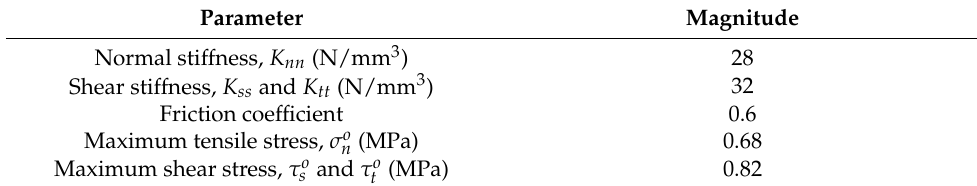
Table 4. Mechanical properties of the cohesive interfaces. Parameter Magnitude Normal stiffness, K nn (N/mm 3 ) 28 Shear stiffness, K ss and K tt (N/mm 3 ) 32 Friction coefficient 0.6 Maximum tensile stress, σ o n (MPa) 0.68 (MPa) Maximum shear stress, τ o s and τ o t